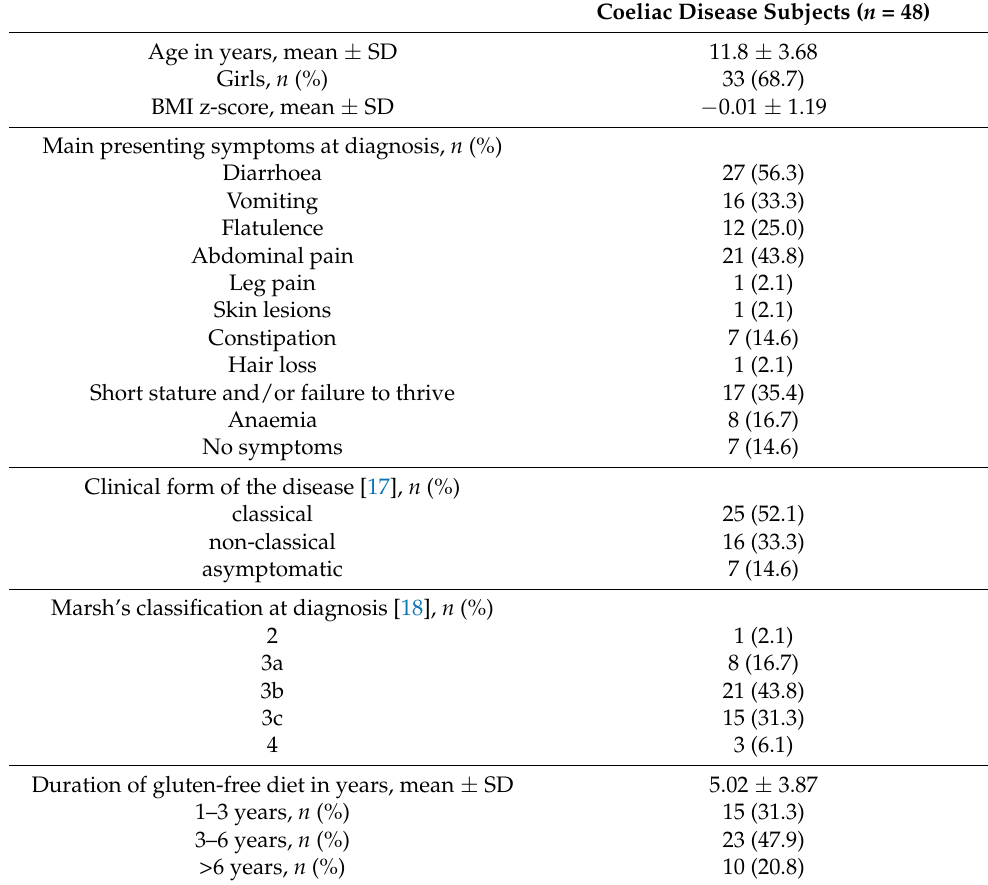
Table 1. Main general characteristics of the coeliac disease subjects on a strict gluten-free